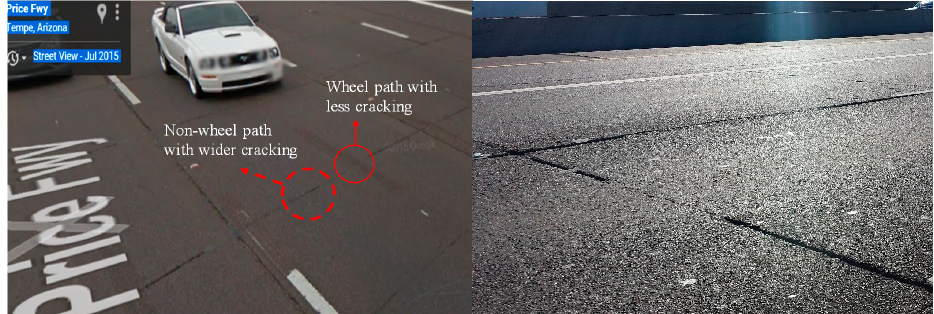
Figure 2. Severity of crack opening comparison in the driving lane between wheel path and non- wheel path (source: left photo Google map-highway 101, Tempe Arizona; right photo captured while driving on highway 202, Tempe, Arizona).